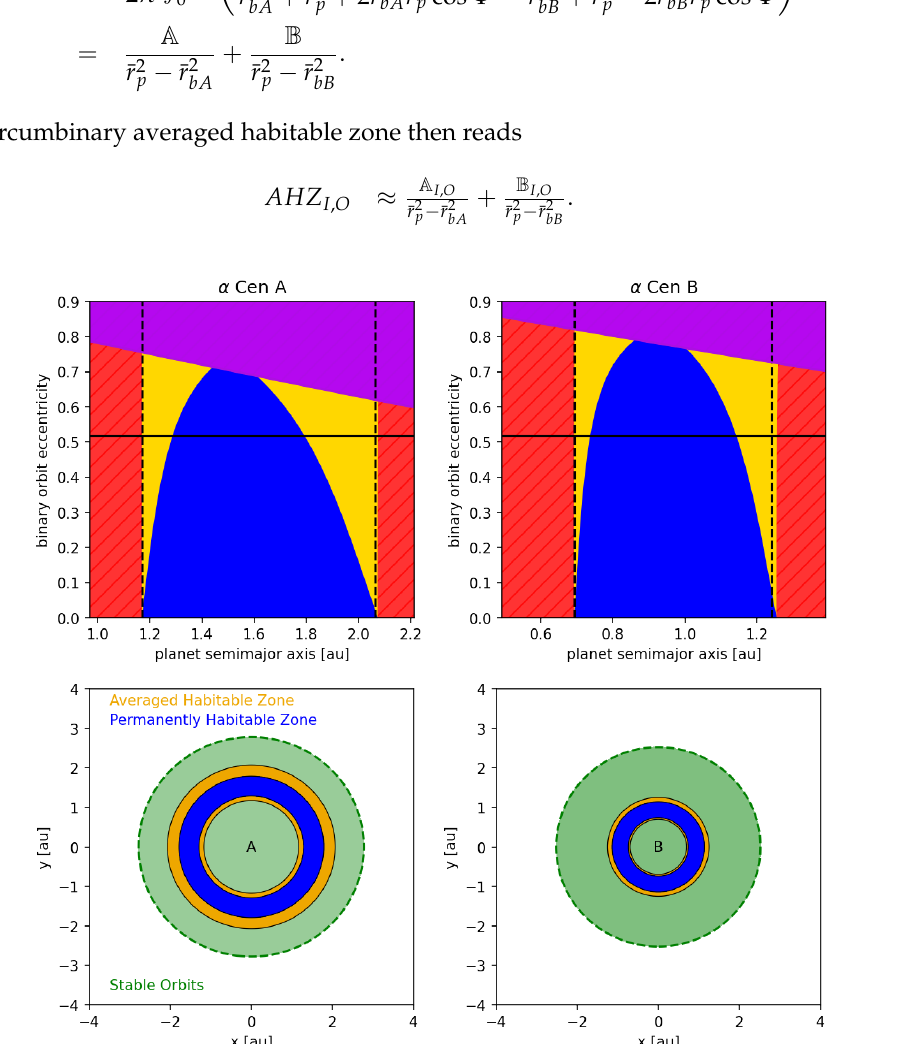
Figure 8. Dynamically informed habitable zones around α Centauri A and B. The top panels show how the extent of dynamically informed habitable zones changes with the orbital eccentricity of the system. Permanently habitable zones (blue), averaged habitable zones (yellow), dynamically unstable zones (purple) and non-habitable regions (red) are presented. The vertical, dashed lines describe single star habitable zone limits. The horizontal line represents the actual α Centauri system. The bottom panels represent a top down view on the actual system. Dynamically stable circumstellar zones around star A and B are colored